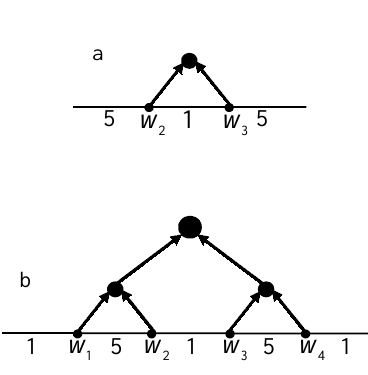
Fig 4 . Firm growth with control cost decrease